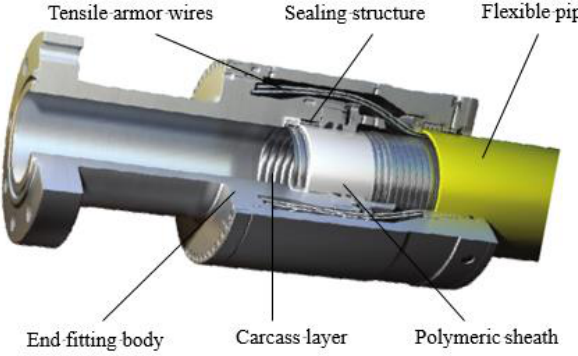
Figure 1. Typical cross-section of flexible pipeline end fitting [9].